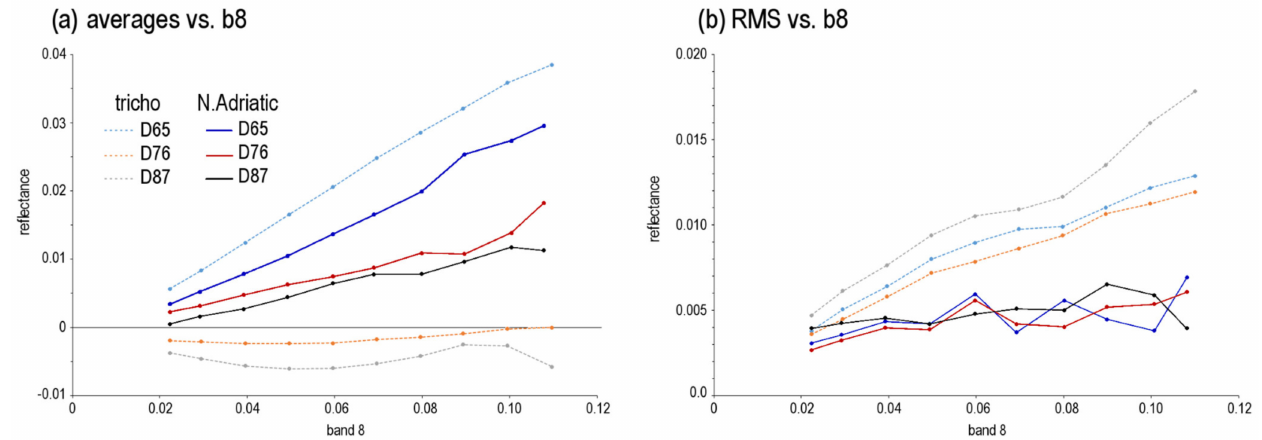
Figure 13. ( a ) Average and ( b ) RMS of D 65 = b 6 − b 5, D 76 = b 7 − b 6 and D 87 = b 8 − b 7 for “trichodesmium” bloom and for North Adriatic